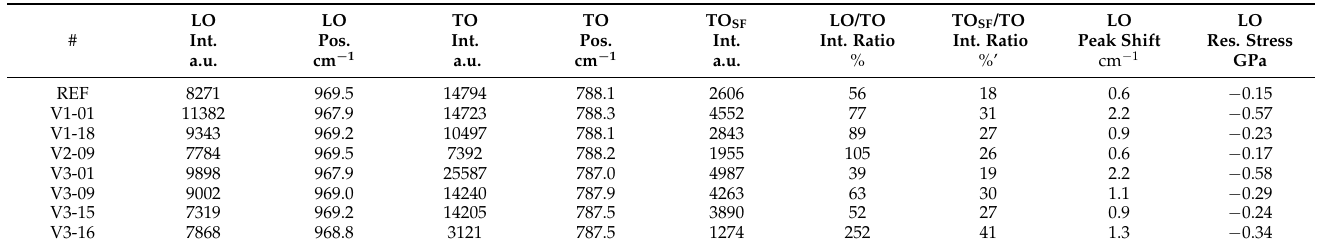
Table 6. Key figures derived from Raman Lorentzian peak fitting, calculated ratios and derived residual stress.